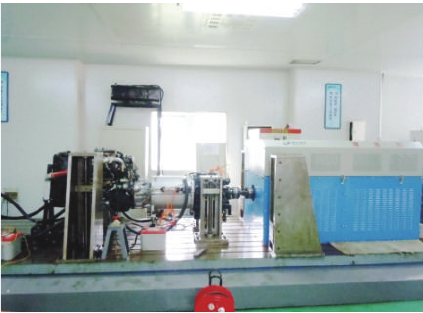
Figure 11: The test bench.